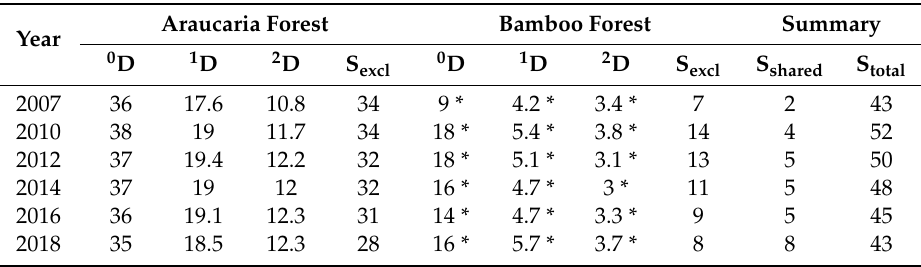
Table 1. Calculated species tree layer diversity for Araucaria Forest (AF) and Bamboo Forest (BF) based on empiric Hill numbers ( q D; q = 0 to 2), number of species exclusive to one forest (S excl ), number of shared species between forests (S shared ), and total number of species in both forests (S total ) ( q = 0 is richness; q = 1 e ff ective number of species where species are weighted in proportion to their frequencies; q = 2 e ff ective number of species where more weight is given to abundant species, discounting rare species). * denotes significant di ff erences based on non-overlapping confidence intervals, see Figure A1 for details).